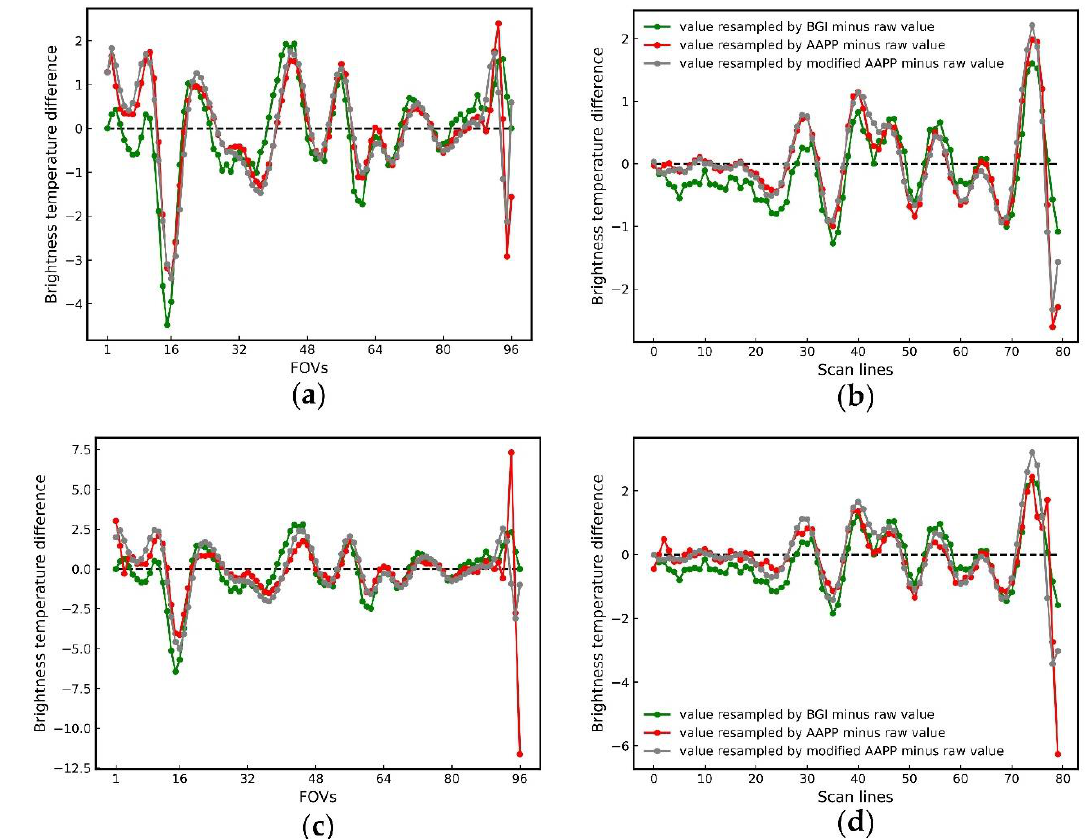
Figure 11. Average brightness temperature differences ( a ) at each FOV with low RMSE, ( b ) at each scan line with low RMSE, ( c ) at each FOV point with high RMSE, and ( d ) at each scan line with high RMSE. The unit of brightness temperature differences is K.